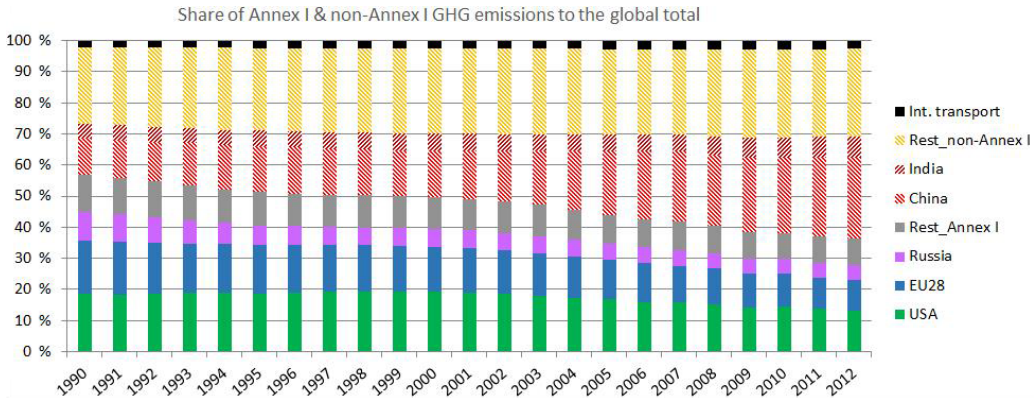
Figure 2. Relative contribution of the Annex I and non-Annex I countries to the global total GHG emissions. The red, brown and orange dashed parts of the stack correspond to the non-Annex I share that increases from about 1 / 3 in 1990 to almost 2 / 3 in 2012.